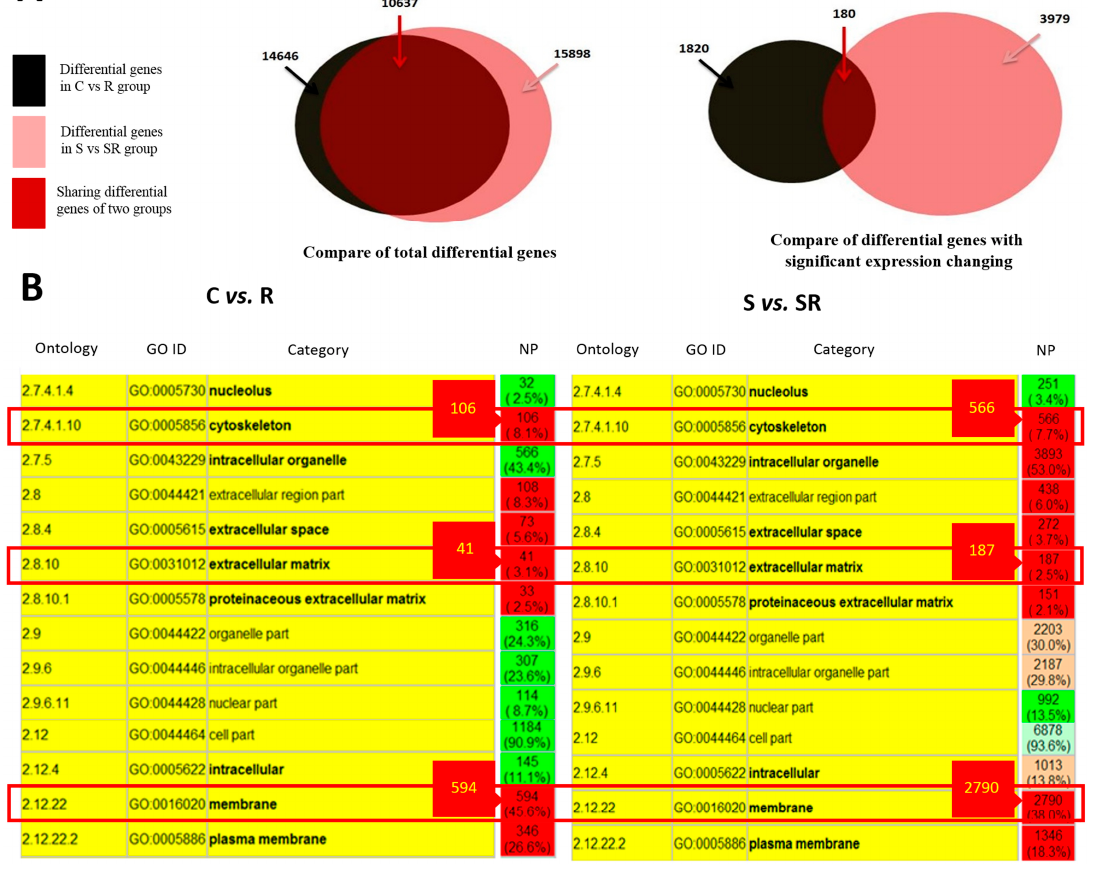
Figure 1. Bioinformatics analysis of differential RNA expression in Control (C) vs. radiation (R) groups and starvation (S) vs. starvation-radiation (SR) groups. ( A ) Differentially expressed genes in C vs. R and S vs. SR groups following transcriptome profiling; ( B ) Gene ontology analysis. A larger number of metastasis-related genes were differentially expressed after radiation treatment in the starvation group. NP, numbers of proteins. Red squares indicate the metastasis-related proteins. Red color in NP column indicates the category significant enriched, pink indicates the category enriched, light green indicates the category depleted, green indicates the category significant depleted.